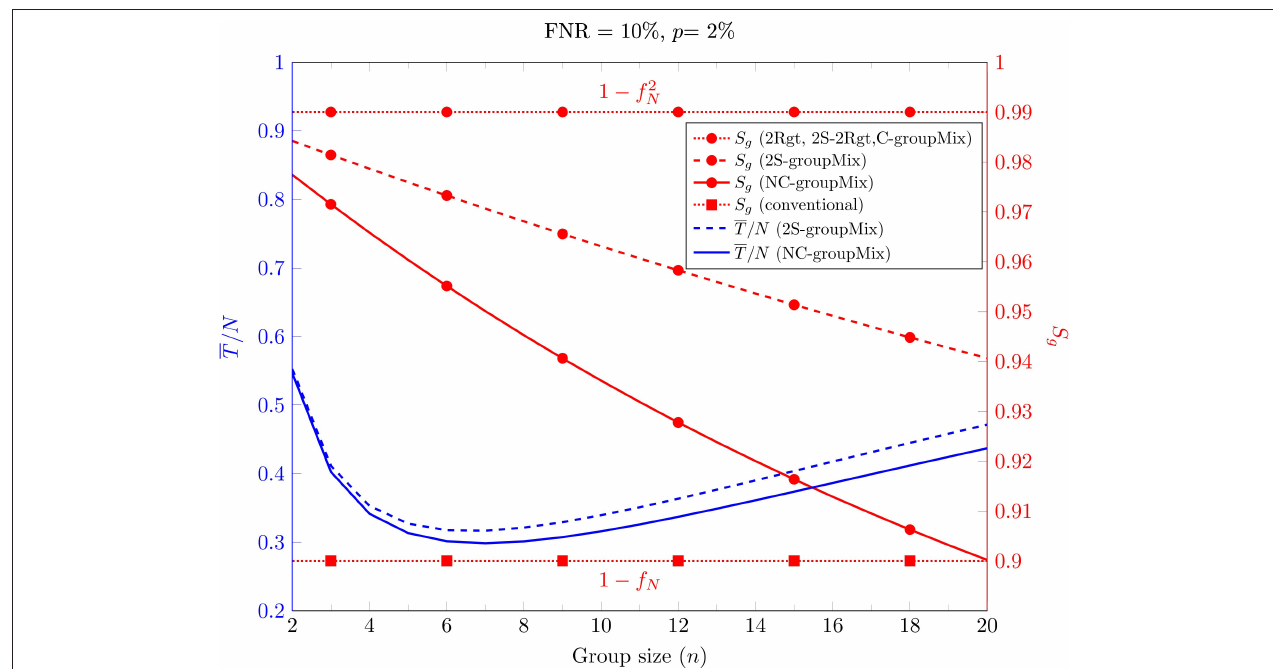
FIGURE 2 | The average number of tests per sample ( left y-axis, blue curves) and group-level sensitivity S g ( right y-axis, red curves) of different methods against the group